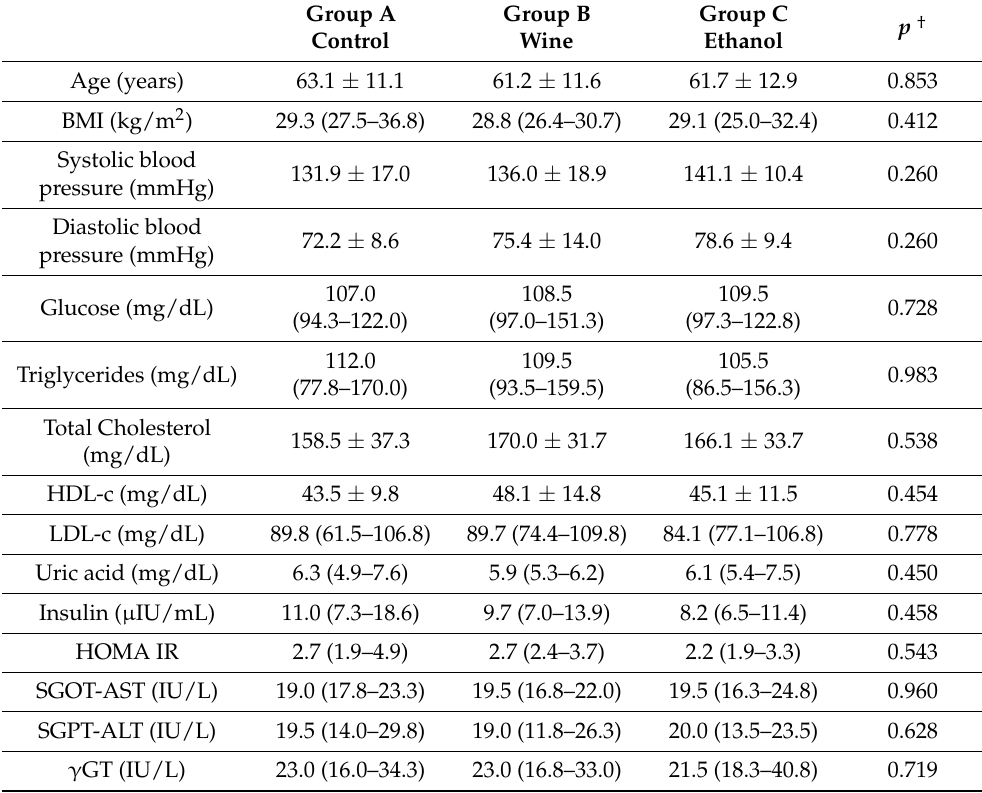
Table 1. Basic biochemical and anthropometric characteristics before intervention (0 weeks).